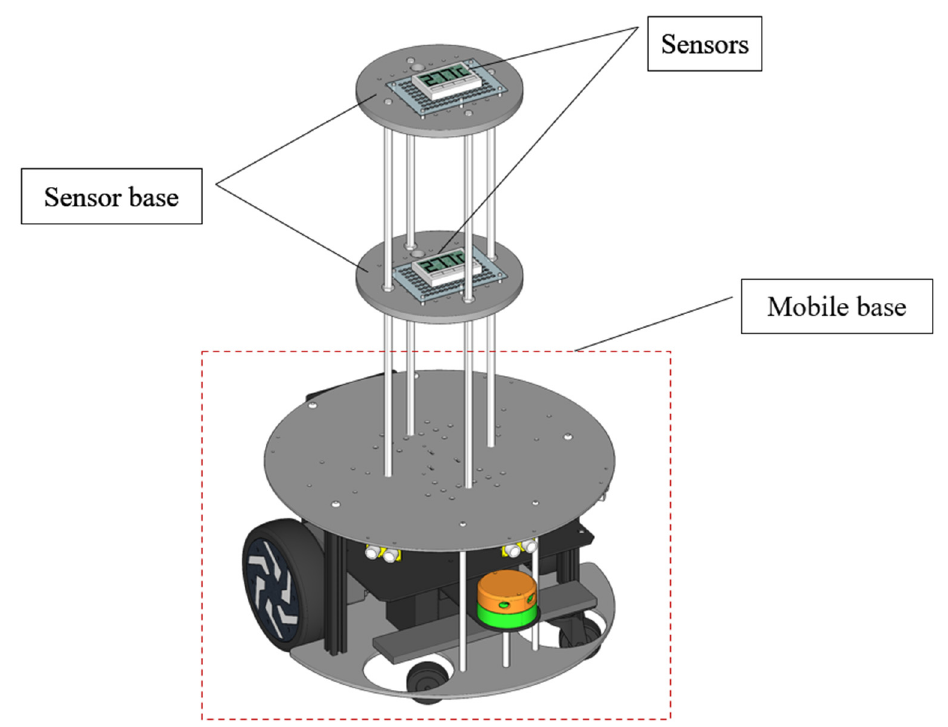
Figure 1. A mobile Figure 1. A mobile sensor.